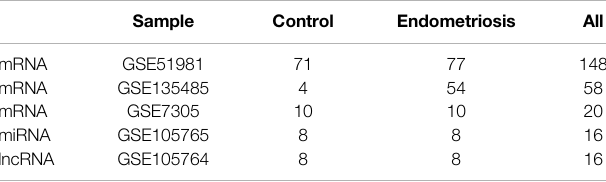
TABLE 1 | Sample information of endometriosis in